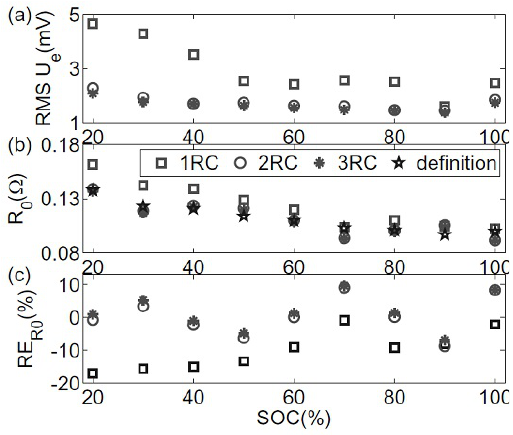
Figure 2. The model performance evaluation: ( a ) voltage error in RMS, RMS U e ; ( b ) ohmic resistance,